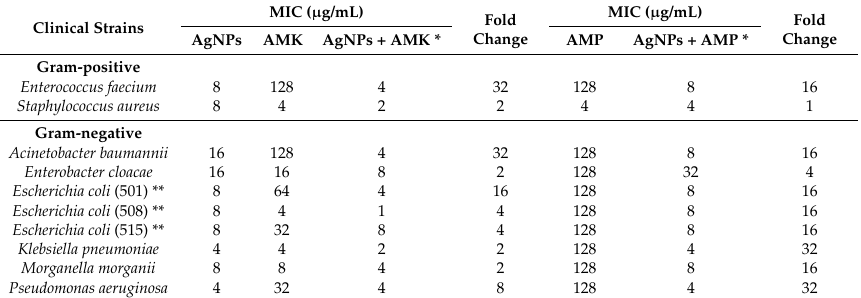
Table 2. Efficacy of silver nanoparticles, antibiotics and their combinations against clinical strains.